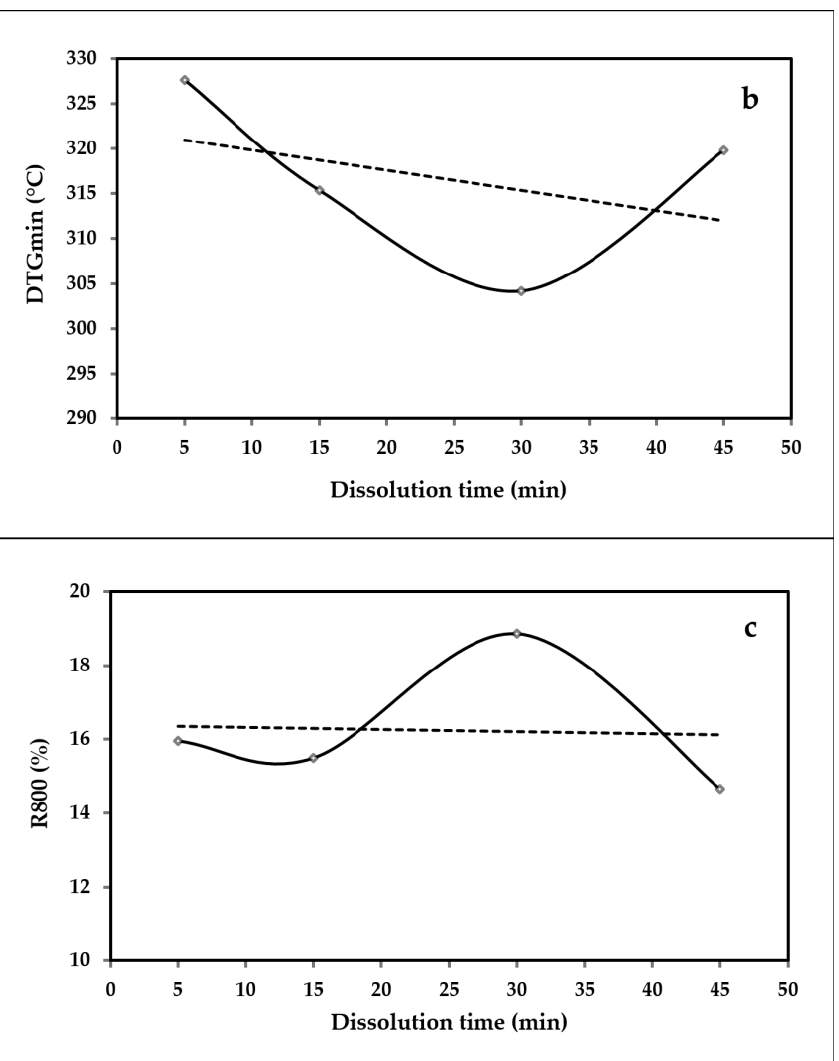
Figure 10. The variations in ( a ) the 50% weight loss temperatures (T w50 ), ( b ) the temperature of the minimum point of the DTG peak (DTG min ), and ( c ) the amount of residual char at 800 °C (R 800 ). Table 5. Thermal properties of the ACC films.